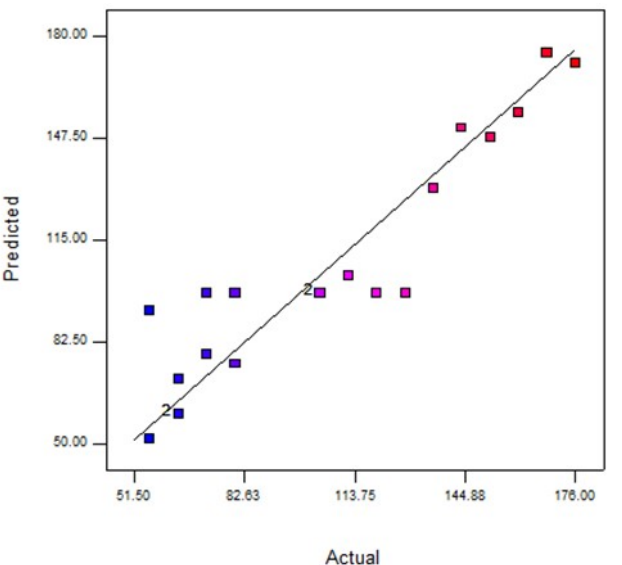
Figure 5. Analysis of predicted and actual response for water flux (L/m 2 · h). Blue dots indicate interaction favours predicted values of water flux and red dots indicate interaction favours actual values of water flux.